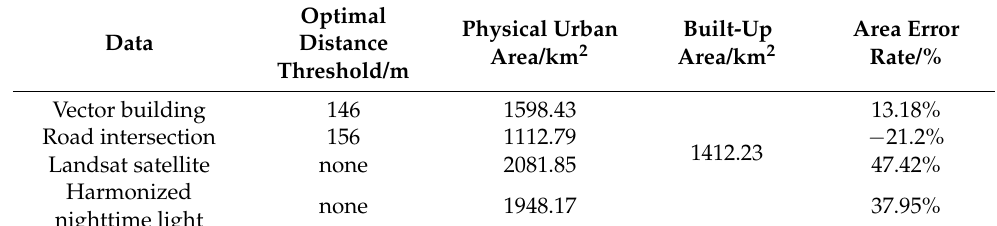
Table 7. Comparison of four data.